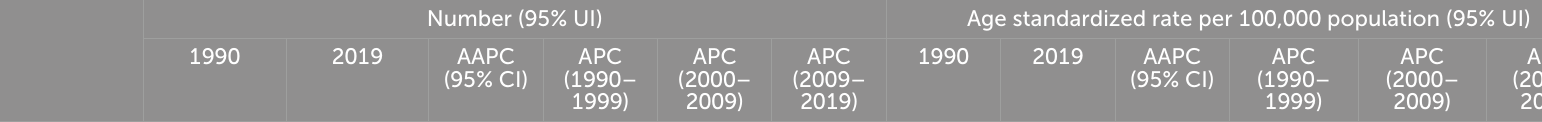
TABLE 2 Trends in the number and age-standardized rate of DALYs and death for level 2 causes attributable to six metabolic risk factors in China,